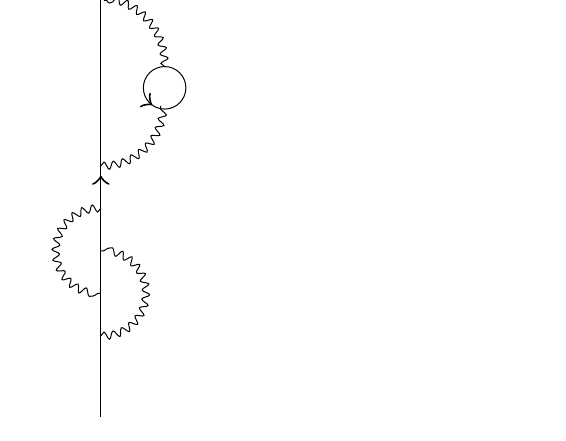
Figure 5 . Feynman diagram corresponding to the ribbon graph shown in figure 6.